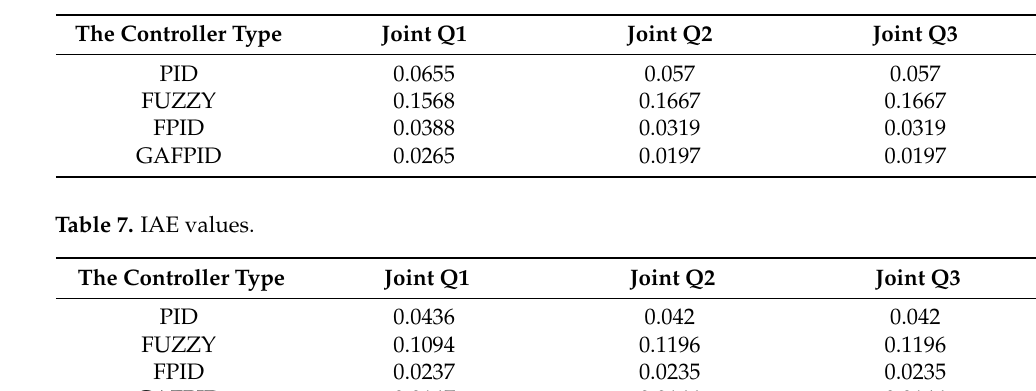
Table 6. ITAE values.